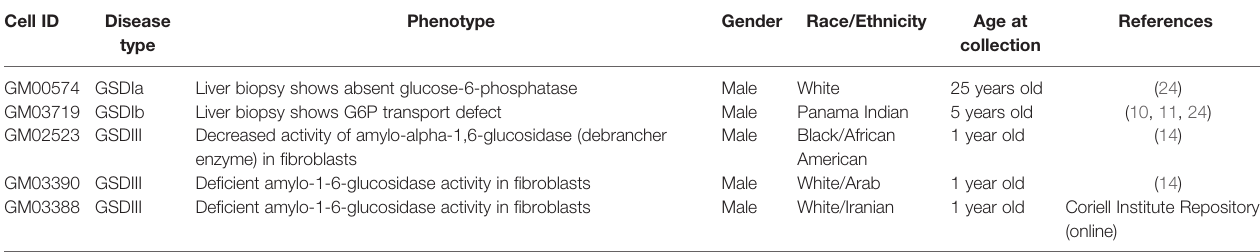
TABLE 1 | Glycogen storage disease dermal fi broblasts employed in this study 1 . Cell